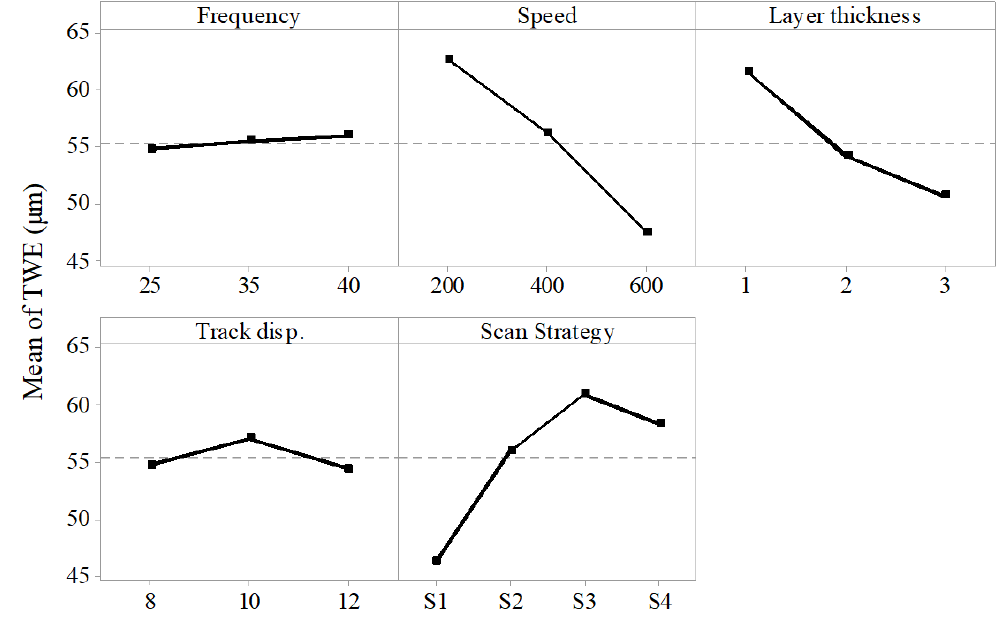
ff ect of process parameters on top-width error Figure 5. Effect of process parameters on top-width error (TWE) . Figure 5. E